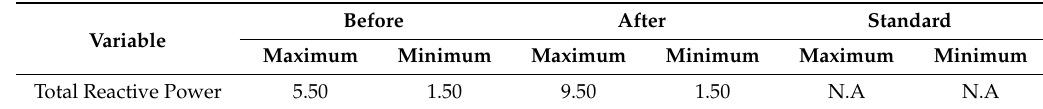
Table 10. Total reactive power values kW.